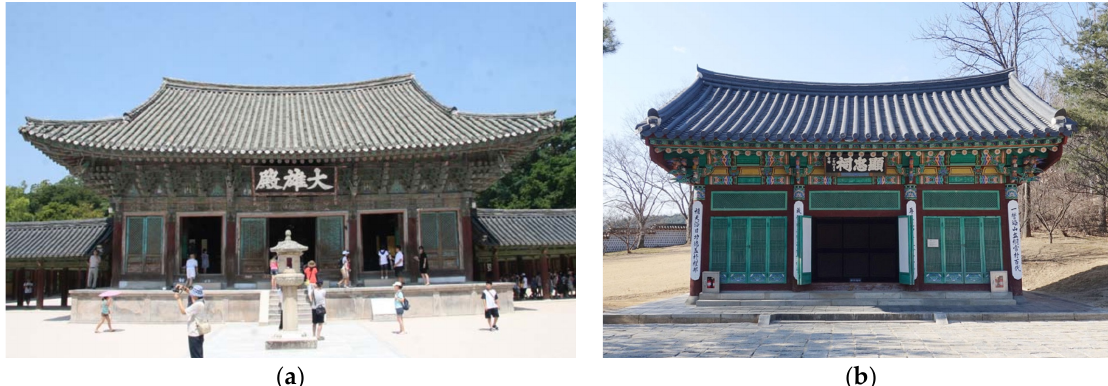
Figure 12. Two Representative Types of Korean Roofs ( a ) Hipped-and-Gabled Roof (Daeungjeon Hall, Bulguksa Temple) ( b ) Gabled Roof (Previous Main Hall of Hyeonchungsa Built in 1932) (Source: Cultural Heritage Administration, Asan City).